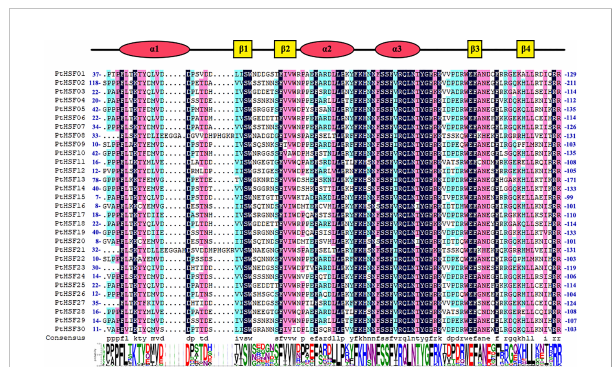
FIGURE 1 Comparison of the HSF domain of PtHSFs. Secondary structure elements of the DBDs ( a 1- b 1- b 2- a 2- a 3- b 3- b 4) based on JNet structure predictions are shown above the alignment; a -helices are indicated by red circular legends, and b -folds are indicated by yellow square legends. The total height of each column of letters in the Web logo section indicates the conservation of each position, and the height of each letter represents the relative rating of the corresponding amino acids.